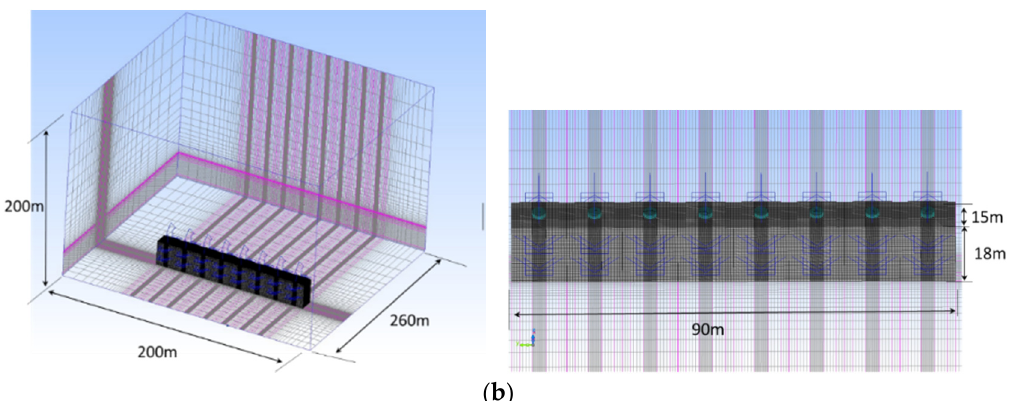
Figure 3 . Analysis model and computed domain in the case of a single cooling tower ( a ) and eight towers ( b ).